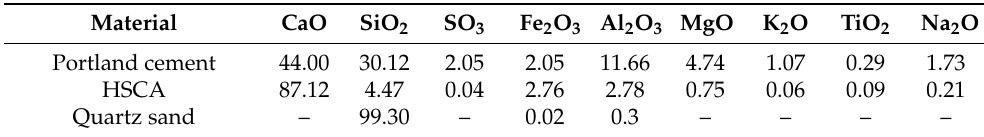
Table 1. Main chemical compositions of grout materials.